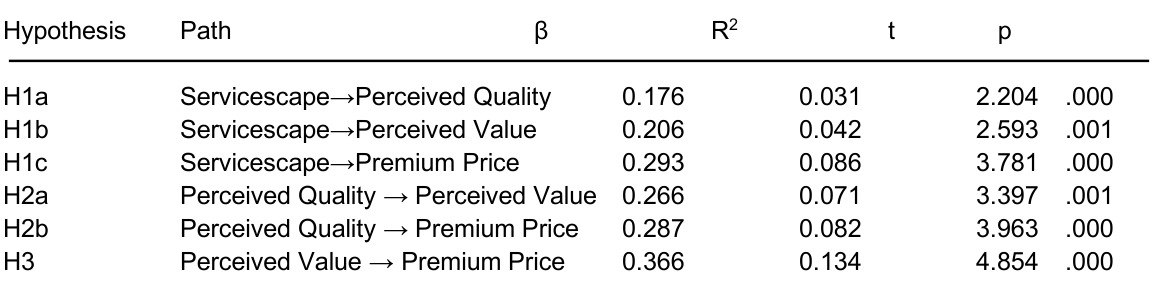
Table 3: Unstandardized Structural